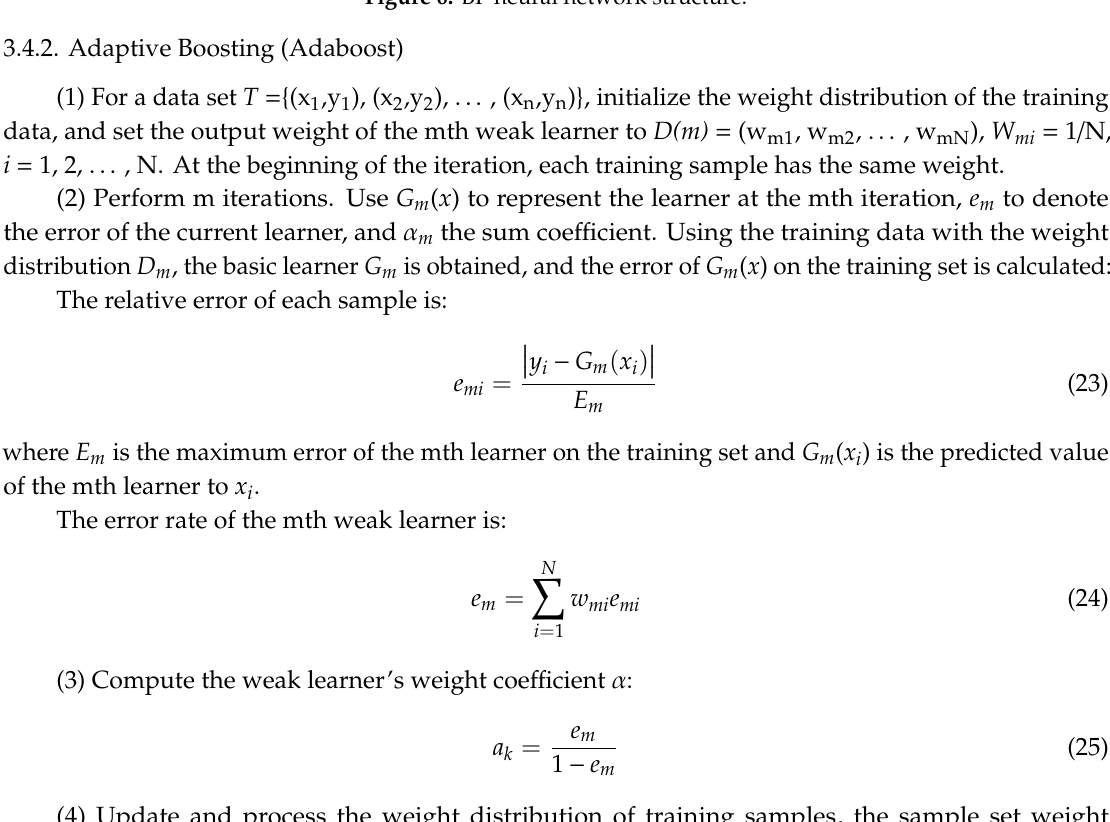
Figure 6. BP neural network structure.